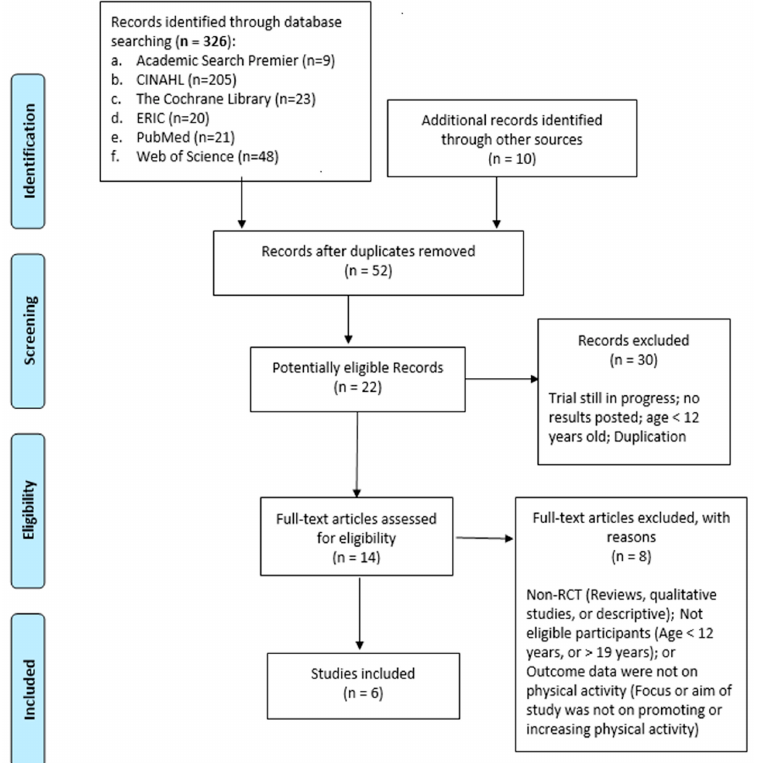
Figure 1. Preferred Reporting Items for Systematic Reviews and Meta-Analyses (PRISMA) http://www.prisma-statement.org.